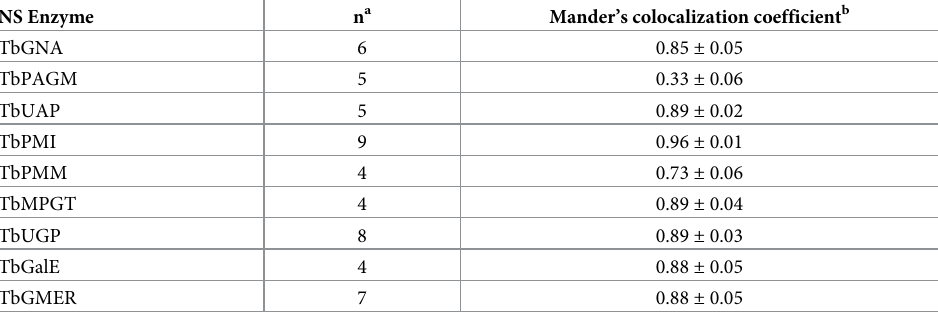
Table 3. Quantitative analysis of anti-NS enzyme and anti-TbGAPDH colocalization by IFM in pcf cells. NS